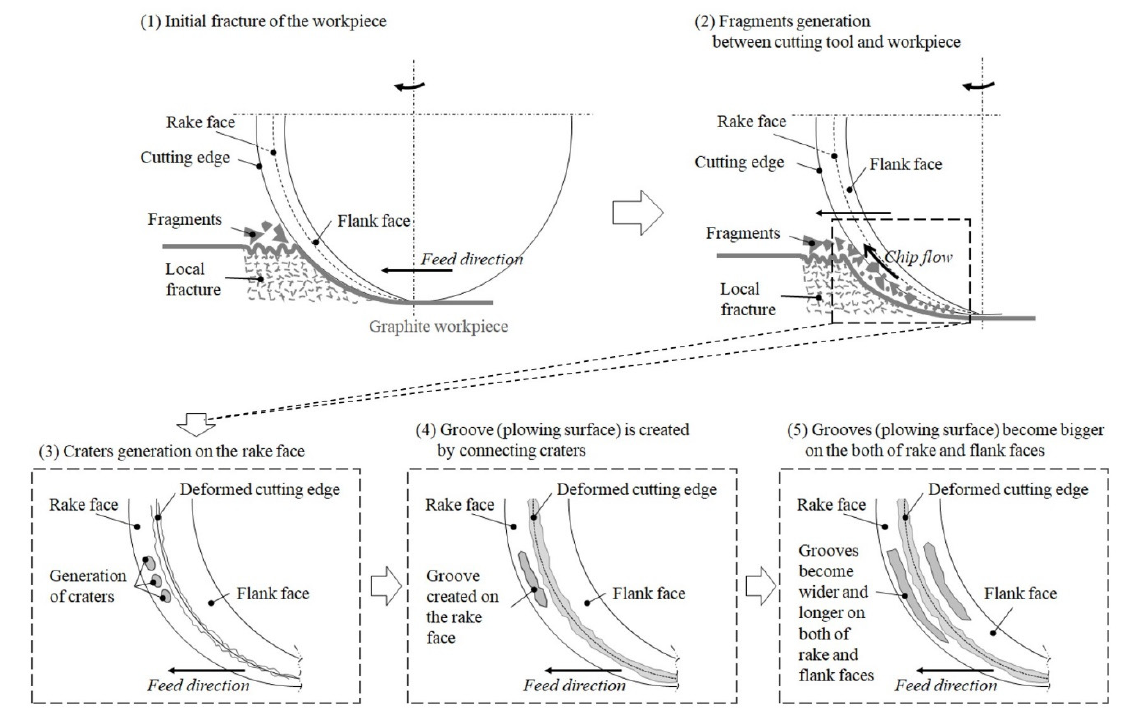
Figure 11. Wearing of flank and rake faces on diamond-coated tool.